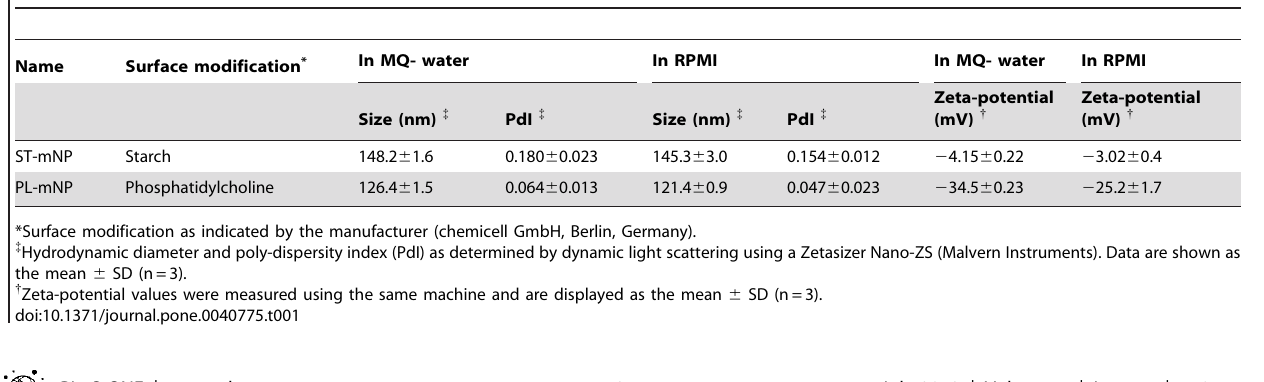
Table 1. Magnetic nanoparticle (mNP) characteristics and properties.